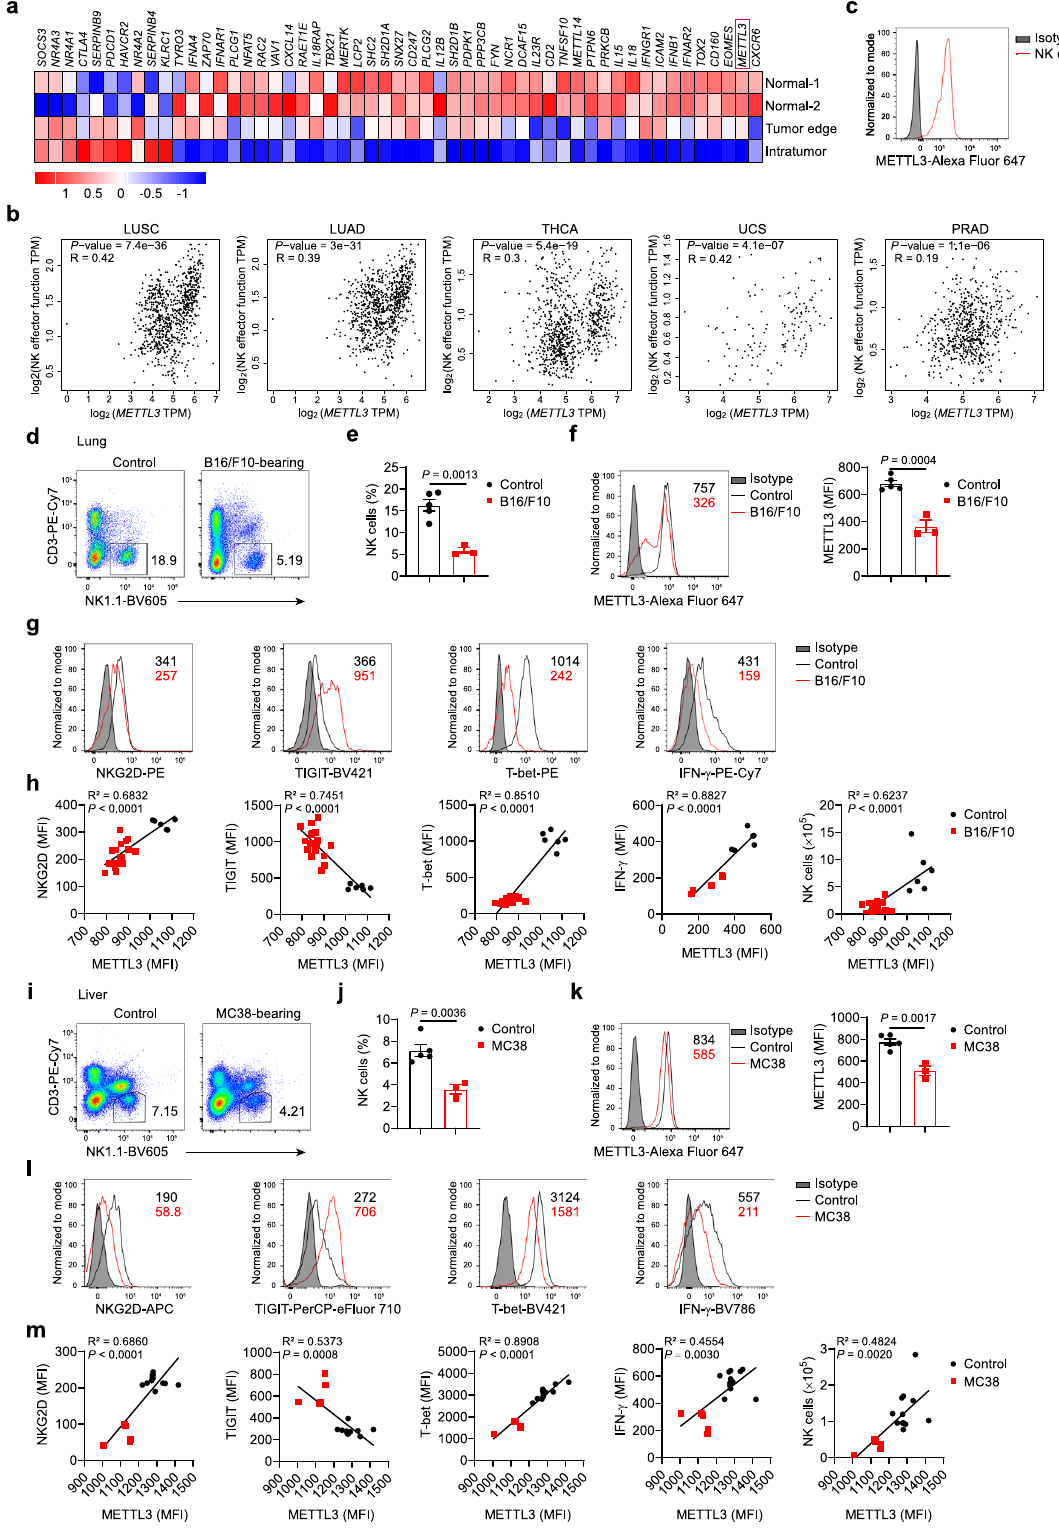
METTL3 protein expression in NK cells. Importantly, the presence of the TGF- β RI inhibitor GW788388 in the culture system counterbalanced the MC38 cell-mediated inhibition